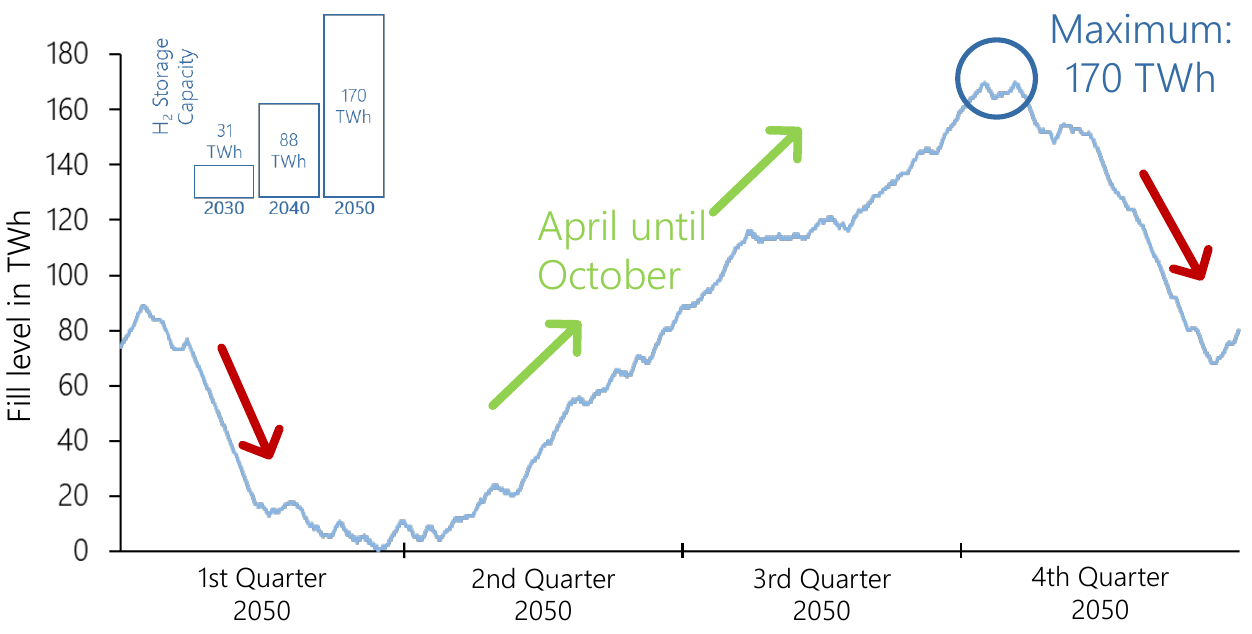
Figure 10. Annual fill level of a hypothetical European hydrogen storage in 2050 as well as maximum storage capacities for the years 2030, 2040, and 2050.